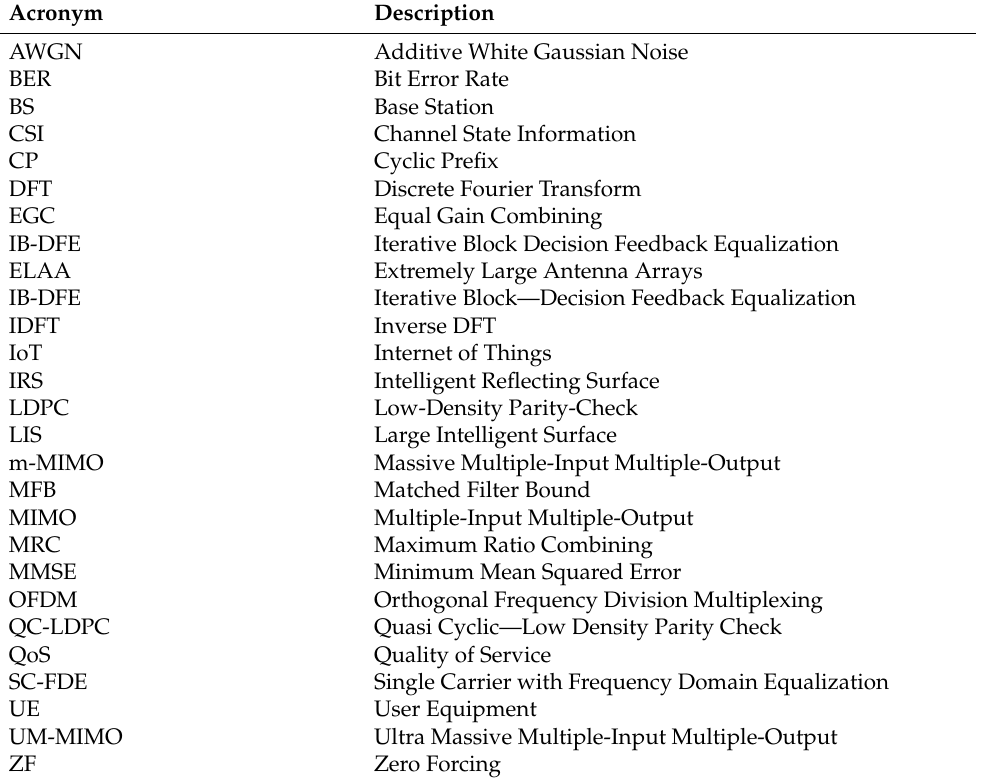
Table 1. A list of